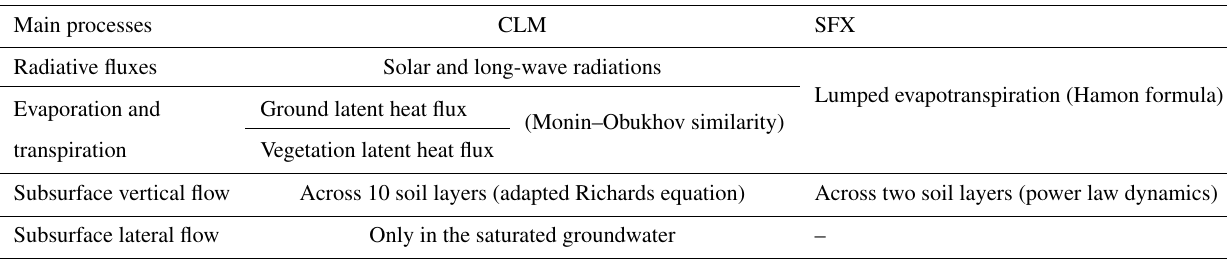
Lumped evapotranspiration (Hamon formula)